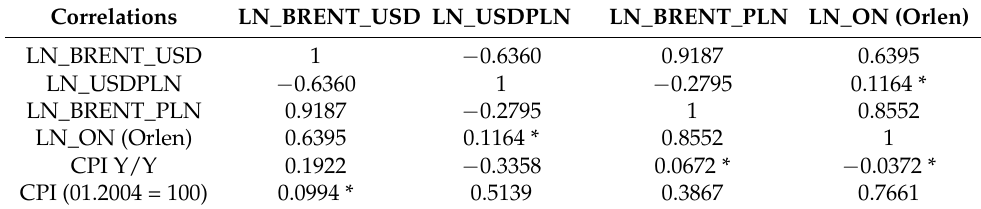
Figure 1. The values of the variables evaluated. ( a ) Stock exchange oil prices and exchange rate; ( b ) Oil and diesel oil prices in Poland; ( c ) Inflation indicators in Poland. The logarithm values of the variables analyzed underwent a correlation study (Table 1). This study can be interpreted in the context of a long-term relationship. Table 1. Correlation connections of the logarithmic variable levels.